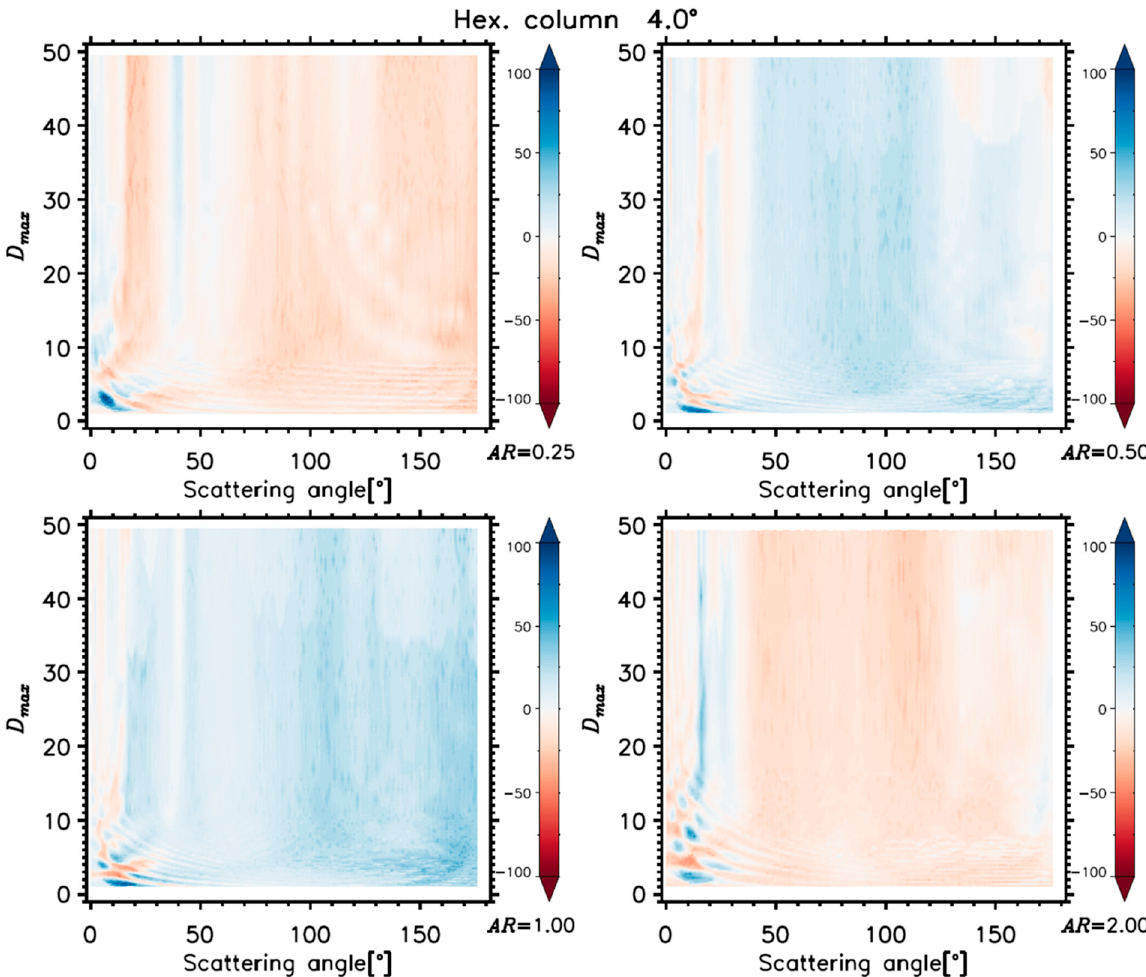
Figure 14. Determined sizing errors (%) as functions of scattering angles and the size ( D max ) of hexagonal ice crystals with AR = 0.25, 0.50, 1.00, and 2.00 using the ADDA for 4° resolution of scattering angles.